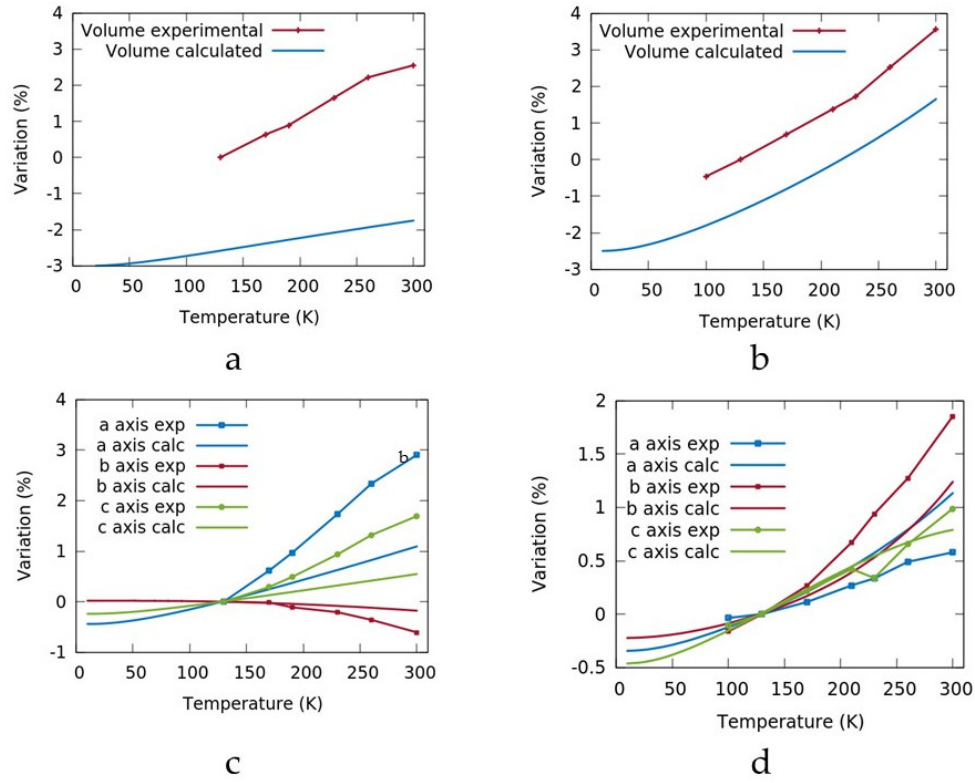
Figure 2. Comparison of the calculated and experimental (dot plot) volume and axes for metoprolol ( a , c ) and betaxolol ( b , d ). The data are normalized with respect to the experimental value at 130 K.